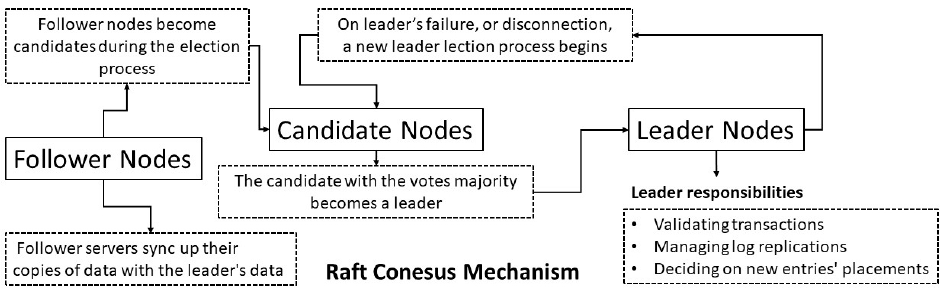
Figure 4. Structure of the Raft consensus mechanism.